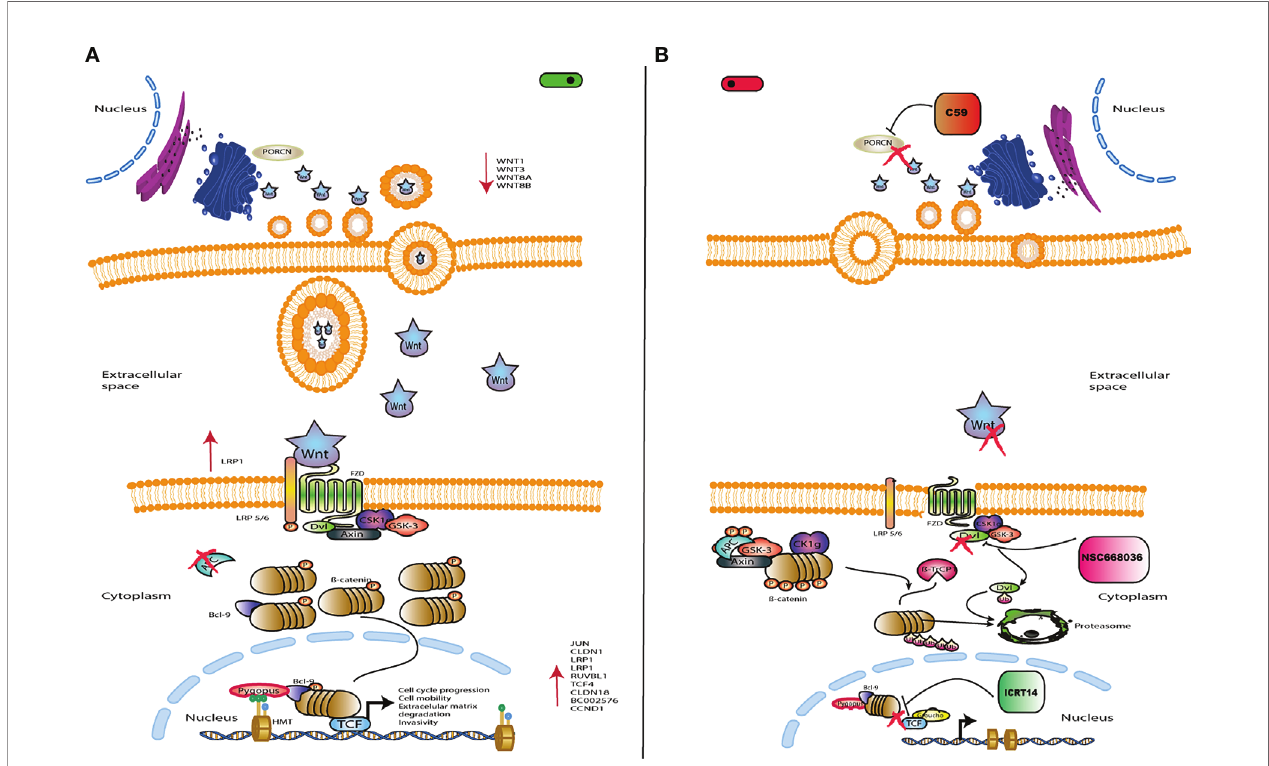
FIGURE 3 | Schematic representation of Wnt/ b -catenin signaling. (A) Wnt/ b - catenin signaling is activated by Wnt ligands, which bind to the FZ/LRP5/6 receptor in order to inhibit the destruction complex. Thus, leading to accumulation of cytoplasmic b -catenin and its eventual translocation into the nucleus. Then, b -catenin binds to TCF/LEF sites to activate transcription of target genes such as CCND1 and MYC, which are involved in cell proliferation and survival. (B) The drug C59 acts at the extracellular level inhibiting the Wnt ligands to block the pathway. NSC668036 acts at the cytoplasmic level binding to DVL protein, which inhibits the Wnt3A induced Wnt/ b - catenin signaling. ICRT14 acts at the nuclear level inhibiting direct interactions between b-catenin and TCF4, blocking the transcriptional function of nuclear b - catenin. Left panel shows the Wnt/ b -catenin signalling pathway turned on; while right panel turned